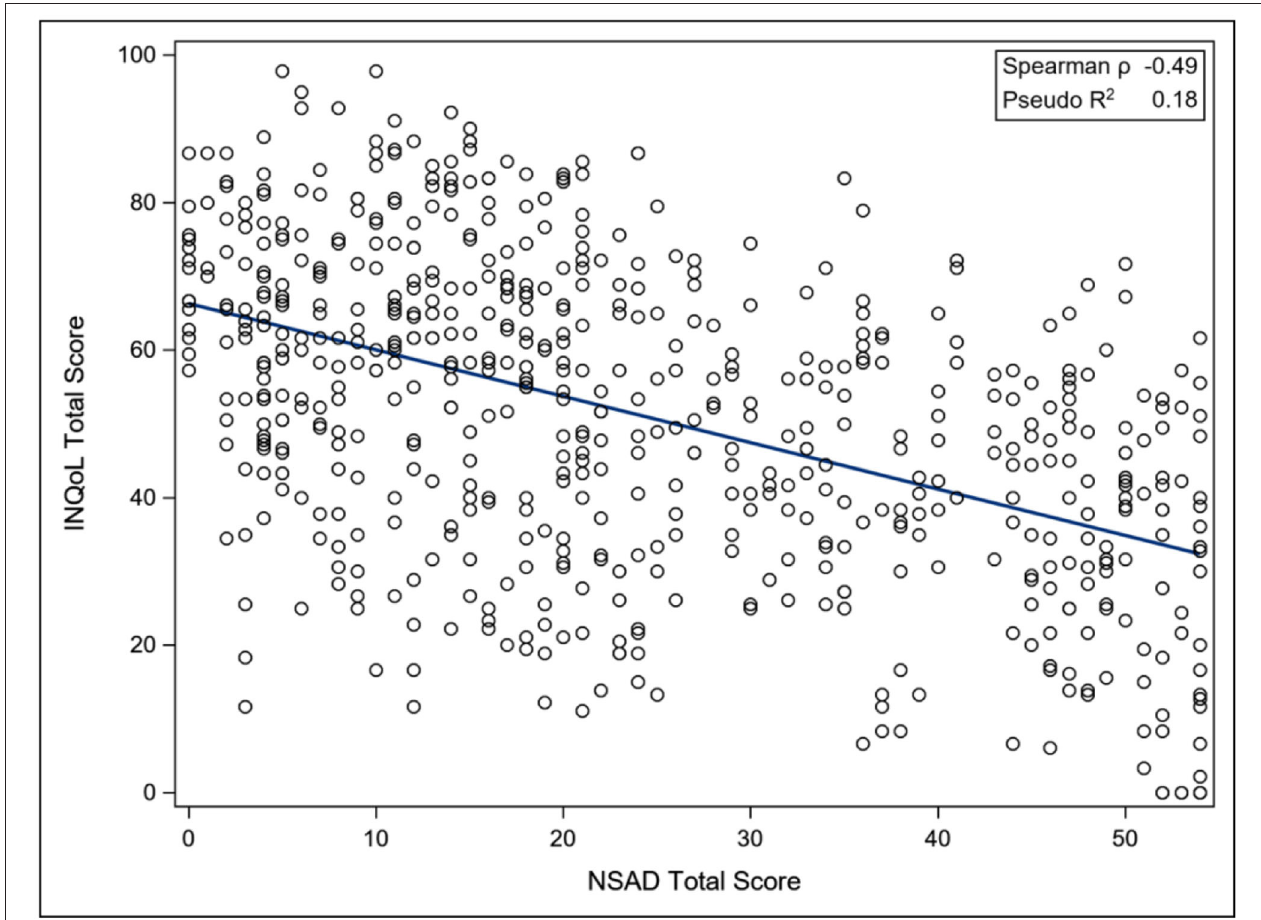
FIGURE 5 | Association between total NSAD score and INQoL. NSAD, North Star Assessment for Limb Girdle Type Muscular Dystrophies; INQoL, Individualized Neuromuscular Quality of Life